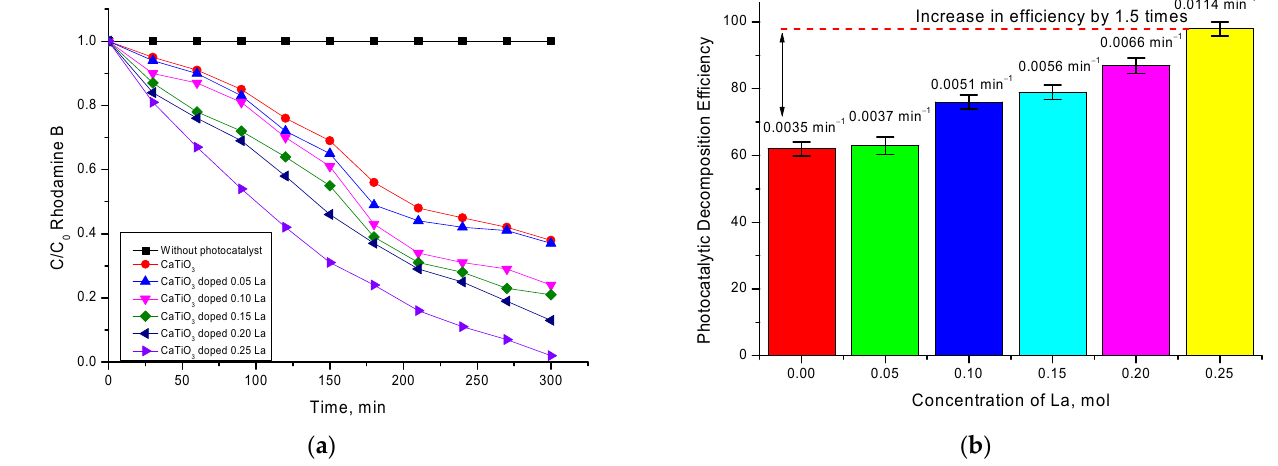
Figure 6. ( a ) Diagrams of Rodamine B concentration dependence on photocatalytic decomposition time; ( b ) Comparative diagram of photocatalytic decomposition efficiency of Rodamine B and reaction rate.